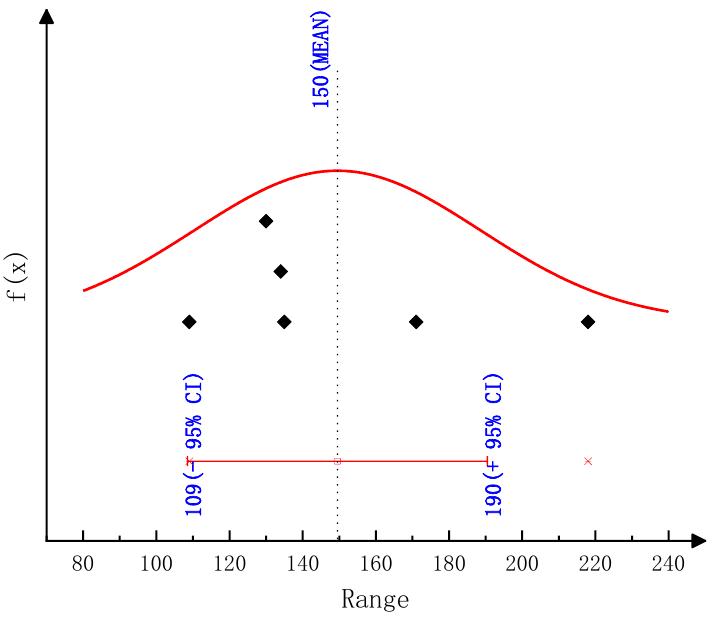
Figure A8. 95% confidence interval for the activation energy E K of CYA pyrolysis reaction.